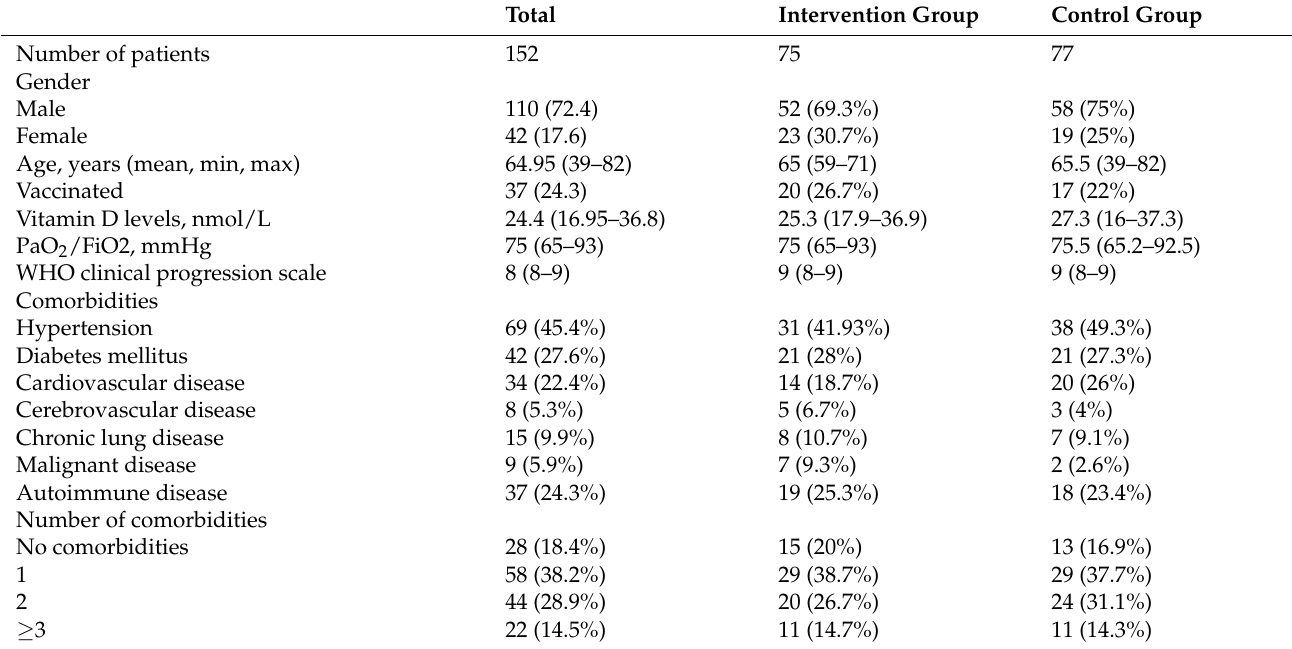
Table 1. Demographic data of patients, vaccination status, vitamin D levels, PaO 2 /FiO 2 ratio, WHO clinical progression scale on admission to